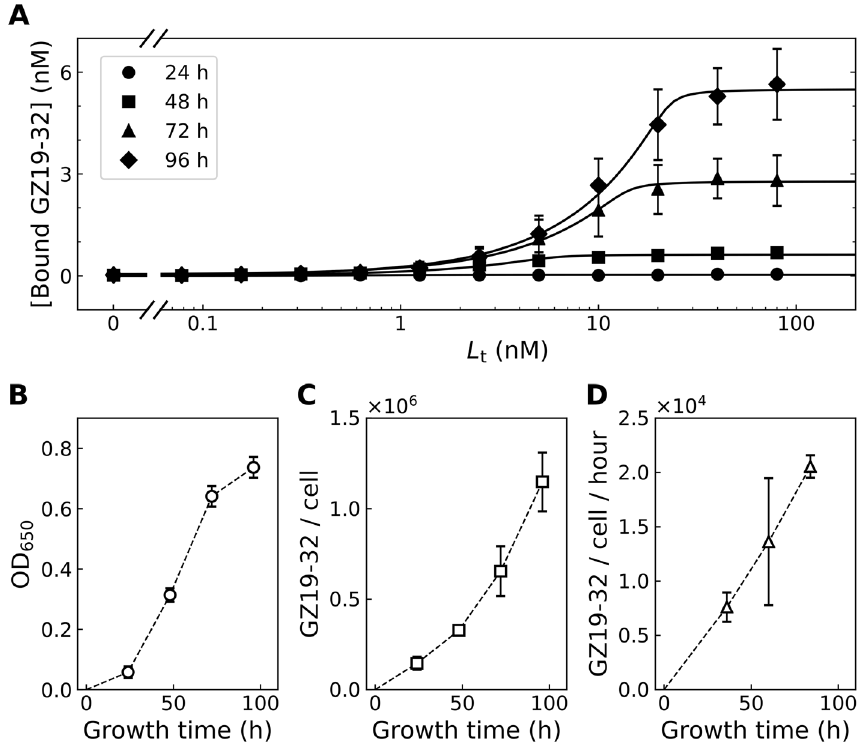
Figure 10. ( A ) The compound dosing profiles of GZ19-32 after growing HeLa cells for 24 (filled circles), 48 (filled squares), 72 (filled triangles), and 96 (filled diamonds) hours under hypoxia. The abscissa axis shows the concentration of added total GZ19-32 to the solution, while the ordinate shows the concentration part of the bound GZ19-32 compound as calculated from the fluorescence. ( B ) The rate of HeLa cell growth